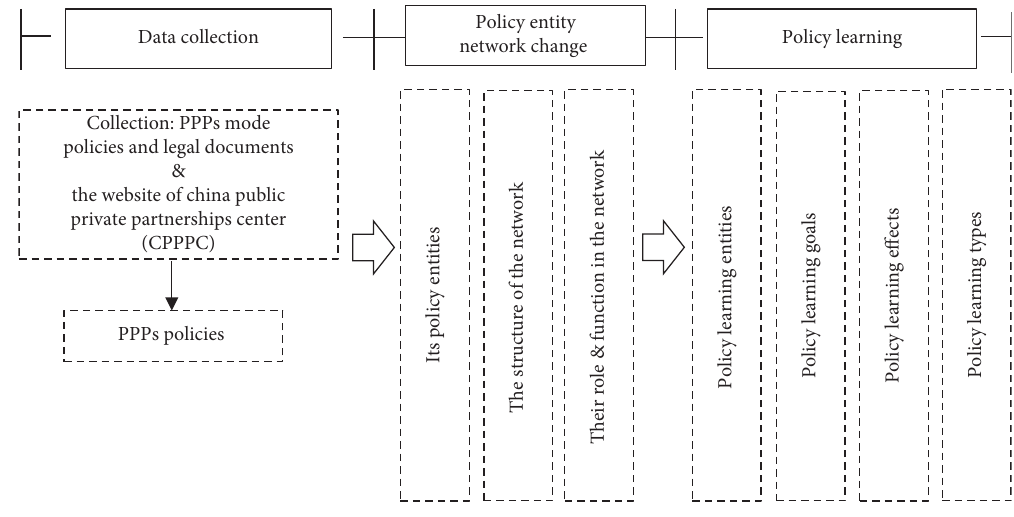
Figure 1: The research